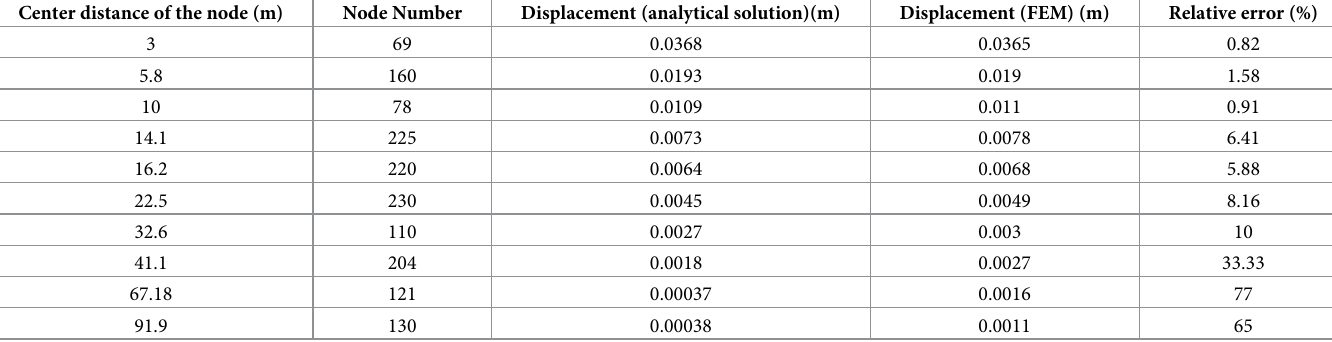
Table 2. Analytical solution and classical FEM numeric solution-comparison of displacement results. Center distance of the node